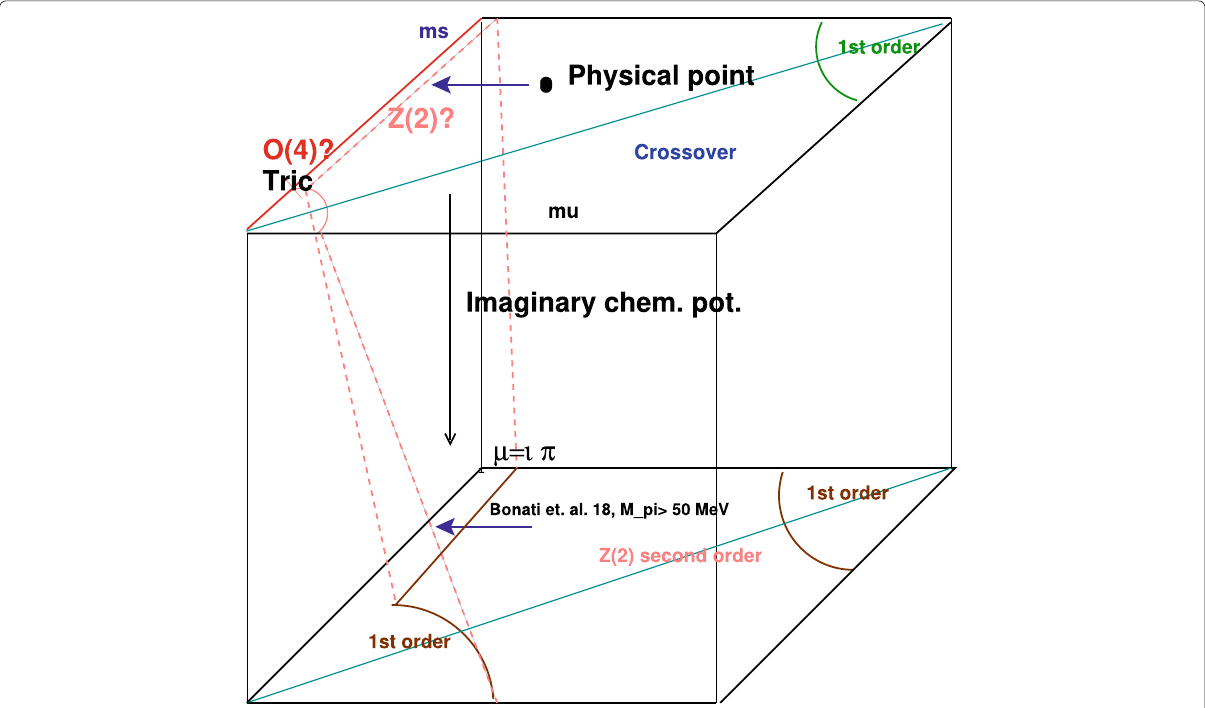
Fig. 3 Current status of the Columbia plot with an additional direction added to it which is characterized by the imaginary baryon chemical potential (which is a third of the quark chemical potential μ q ) normalized by the temperature, μ B / T , taken from [11]. The lower plane is the current understanding we have of the generalized Columbia plot at μ B / T = 3 μ q / T = i